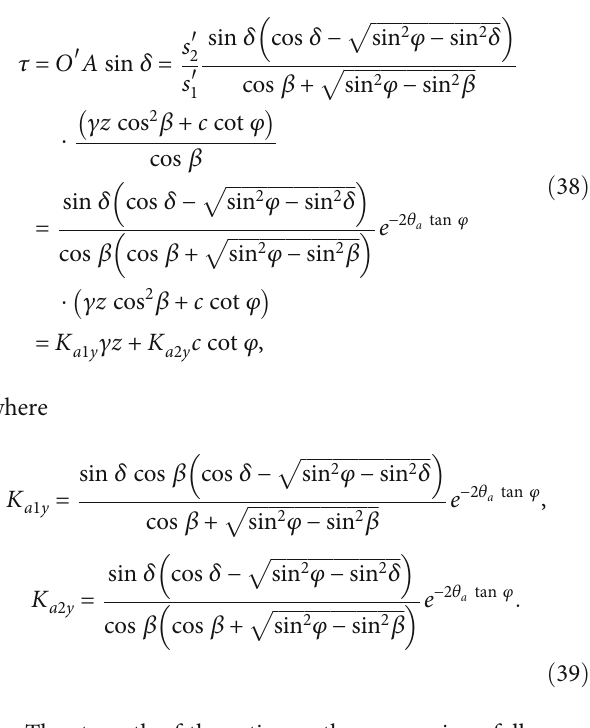
Figure 4: Retaining wall under active limit According to stress circle 2 (Figure 5) after de fl ection of